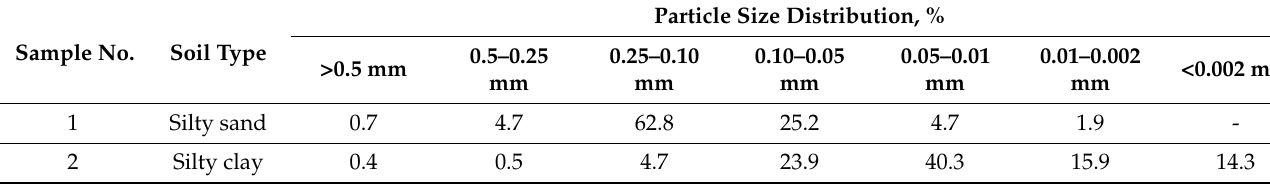
Table 2. Particle size distribution of investigated